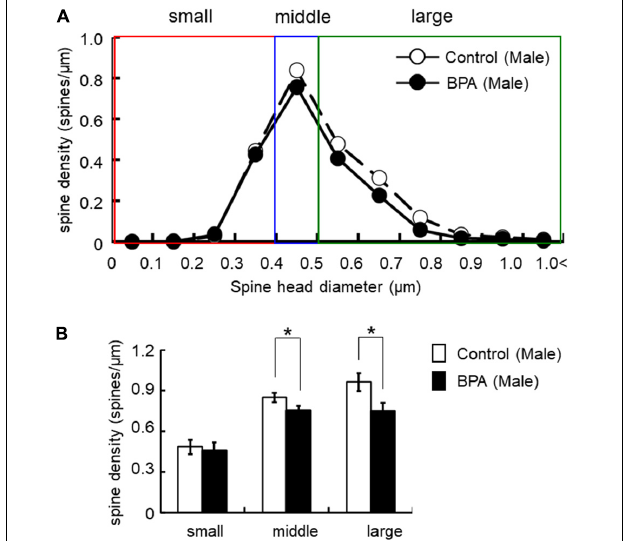
FIGURE 3 | Changes in the morphology of spines upon perinatal exposure of BPA in the hippocampus of grownup male rats. (A) Histogram of spine-head diameters without BPA (control, open circle) or with BPA (BPA, filled circle) in male rats. (B) Density of three subtypes of spines, from left to right: small-, middle-, large-head spines. Results are represented as mean ± SEM. In each group, the white and black columns are expressed for the control and BPA-treated data, respectively. We investigated 6 rats, 13 slices, 25 neurons, 50 dendrites, ∼ 5700 spines for male control and 8 rats, 13 slices, 26 neurons, 51 dendrites, ∼ 5000 spines for male BPA. The significance of the BPA effects was confirmed via statistical analysis using t- tests. Statistical significance yielded * p <